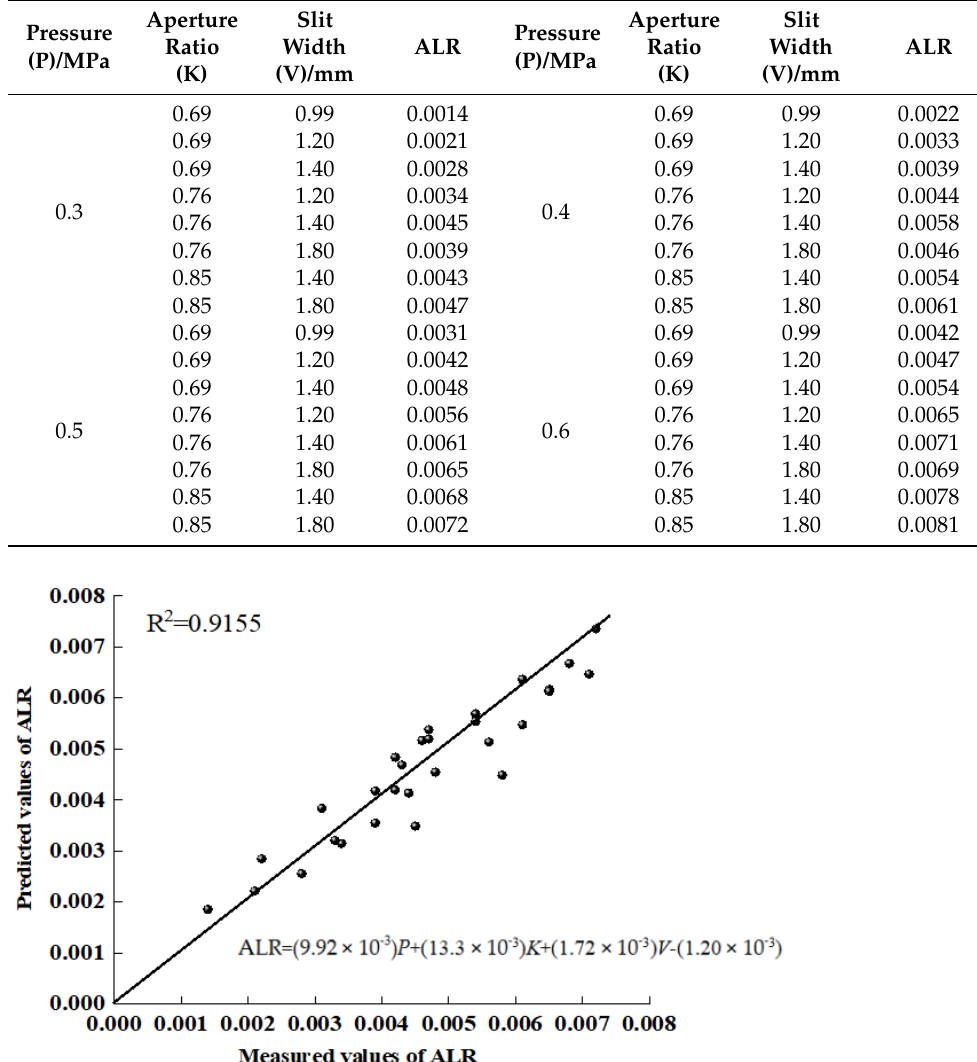
Table 3. Test protocols and results.